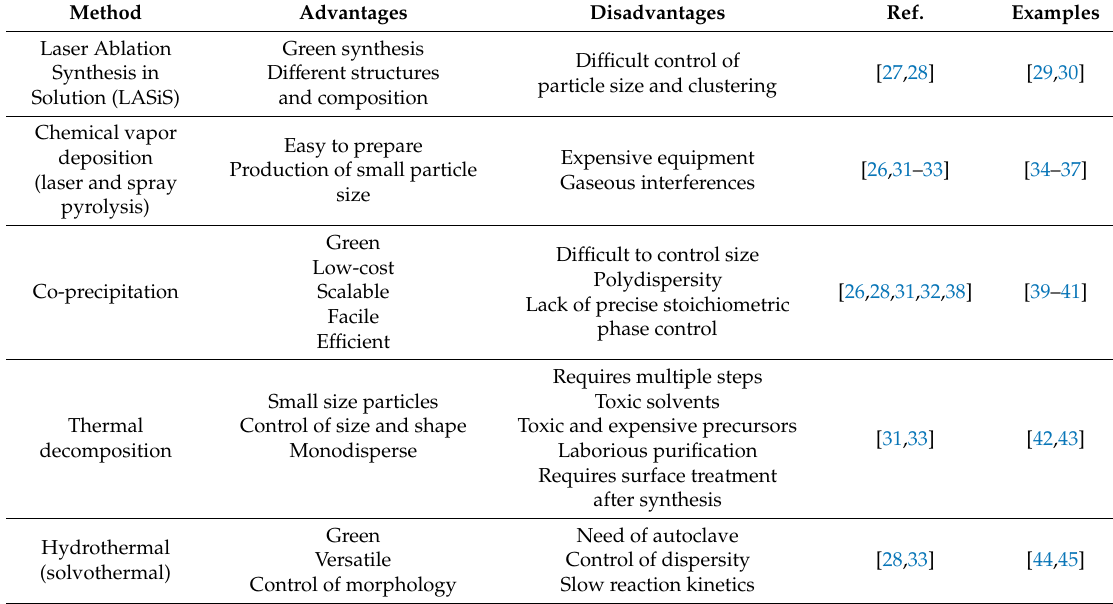
Table 1. Common methods used in the synthesis of iron oxide nanoparticles, advantages and disadvantages, and references. Examples of isotropic and anisotropic shape nanoparticles are